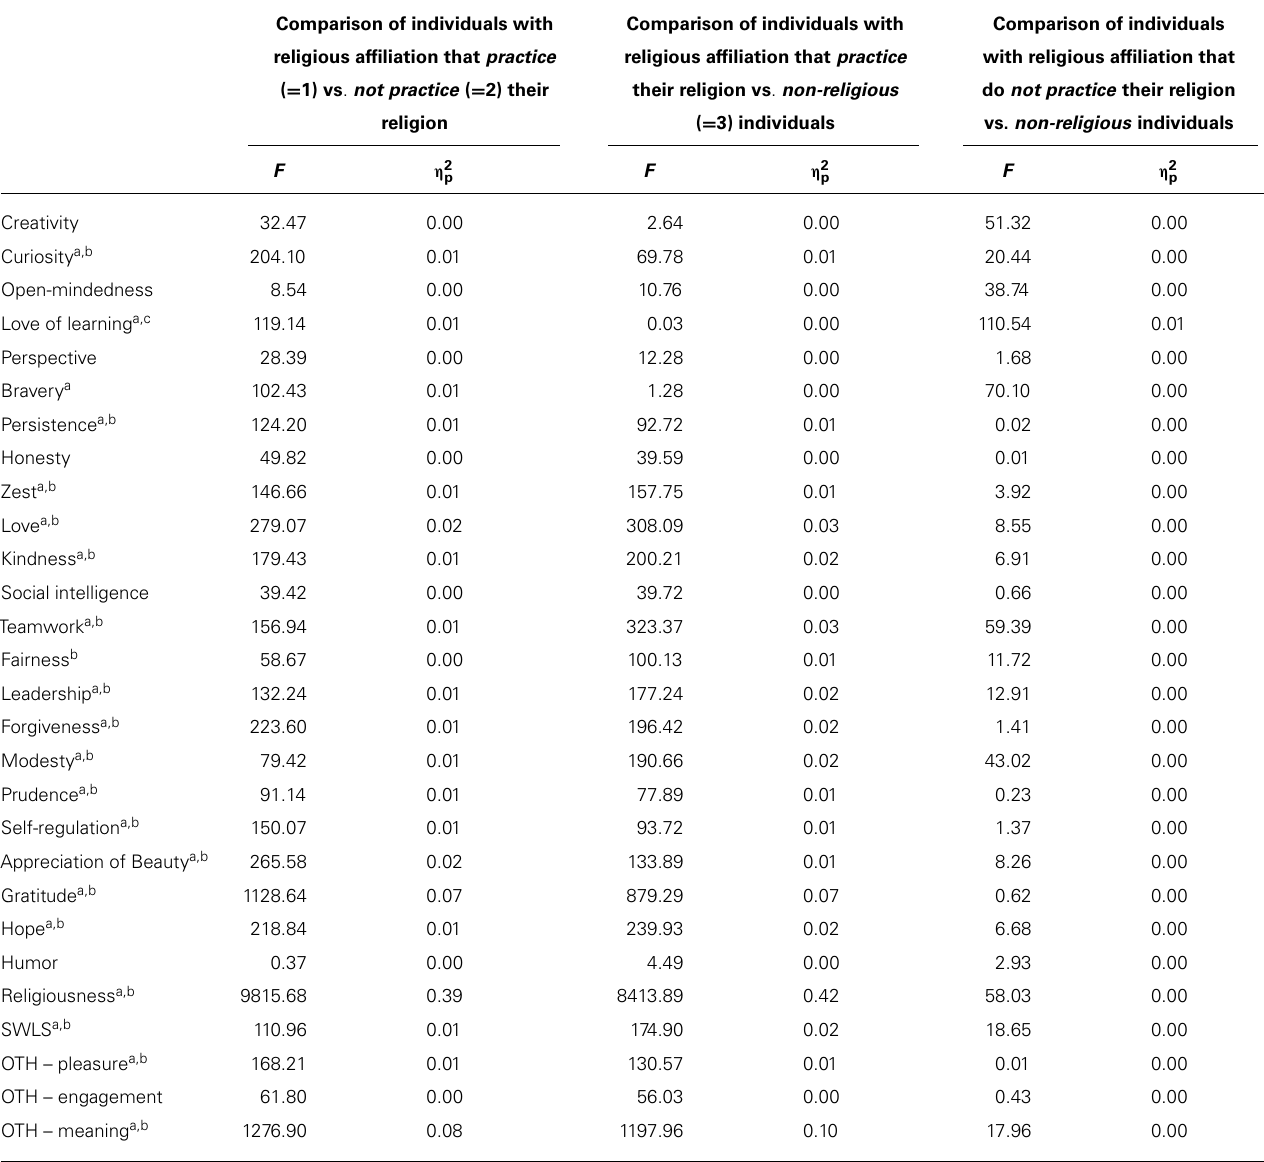
Table 2 | F -values for the comparison of the three groups regarding character strengths, SWLS, and OTH. Comparison of individuals Comparison of individuals with Comparison of individuals with with religious affiliation that religious affiliation that practice religious affiliation that practice do not practice their religion their religion vs . non-religious ( = 1) vs . not practice ( = 2) their vs. non-religious ( = 3) individuals religion